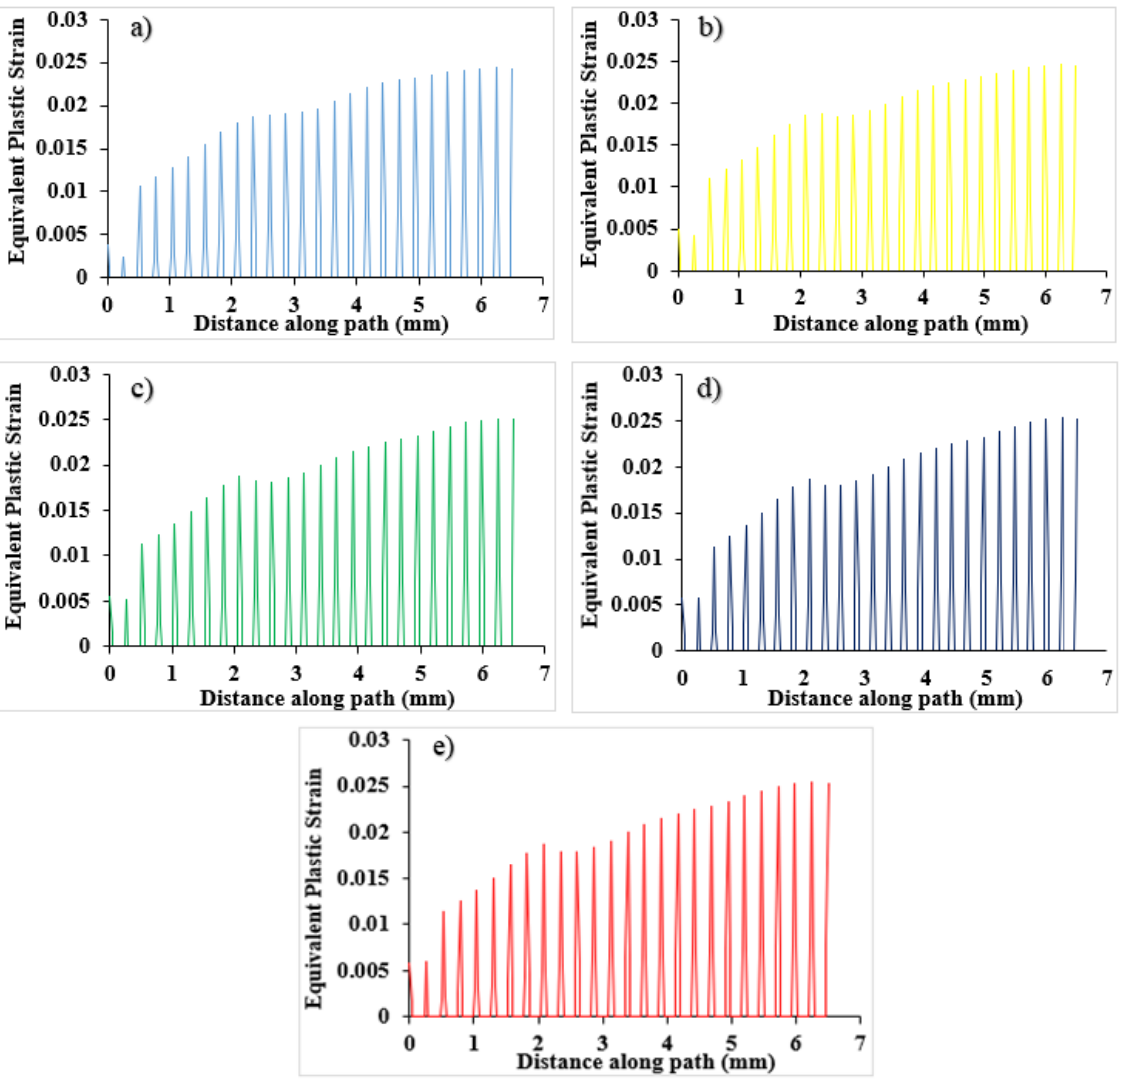
Figure 16. Equivalent plastic strain diagram in Path 1 in ( a ) Cycle 1, ( b ) Cycle 2, ( c ) Cycle 3, ( d ) Cycle 4, and ( e ) Cycle 5.